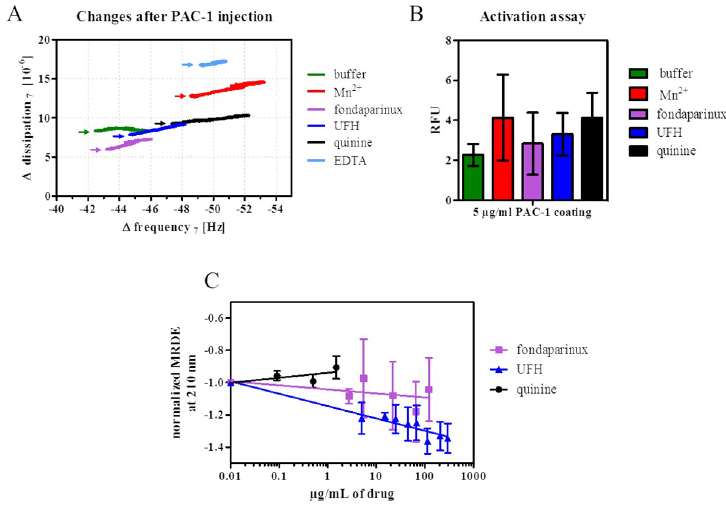
Fig 5. α IIb β 3 activation by drugs. A) Changes in frequency ( Δ f ) and dissipation ( Δ D ) after PAC-1 injection event (indicated by the respective arrows) in representative QCM-D experiments with proteoliposomes after treatment with buffer (green), 1 mM Mn 2+ (red), 250 μ g/mL fondaparinux (purple), 50 μ g/mL quinine (black), 250 μ g/mL UFH (blue) and 5 mM EDTA (light blue) for at least 15 min at 37˚C. B) Drug activation assay using PAC-1 antibody. Each value is the mean of three replicate measurements ± SEM. The binding of PE CF-liposomes/proteoliposomes to 5 μ g/mL PAC- 1 coated to a microtiter plate was detected after the incubation with buffer (green), 1 mM Mn 2+ (red), 250 μ g/mL fondaparinux (purple), 250 μ g/mL UFH (blue) and 50 μ g/mL quinine (black). Liposome sample results were subtracted from proteoliposomes values. The y-axis shows relative fluorescence units (RFU). C) Normalized single wavelength plot for corresponding MRDE values at 210 nm from far-UV region CD spectra of α IIb β 3 incorporated into liposomes/proteoliposomes treated with increasing concentrations of UFH (blue), fondaparinux (purple) and quinine (black), respectively. Normalized averages from three independent measurements ± SEM are shown as dots that were recorded with proteoliposomes with a protein concentration of approximately 0.4 μ M or liposomes in 5 mm path length cuvettes at 37˚C. Liposomes spectra were subtracted from the respective proteoliposome spectra. Respective trendlines were applied to guide the